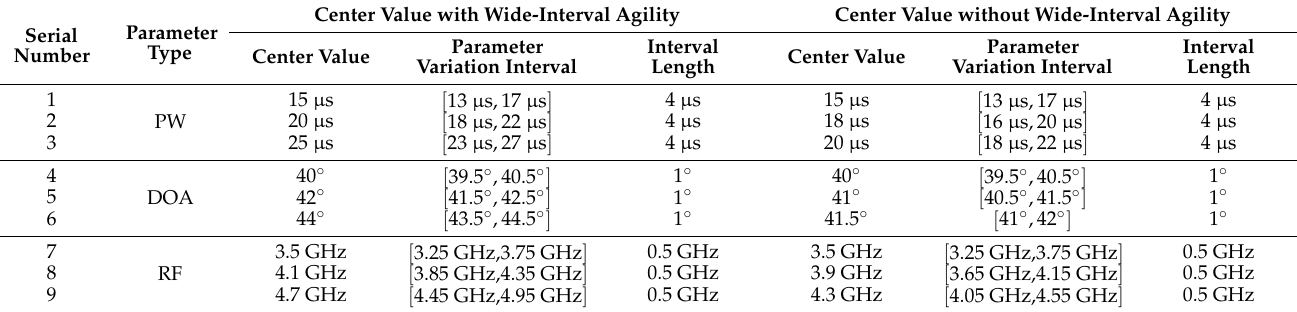
Table 1. Parameter setting of signal simulation.